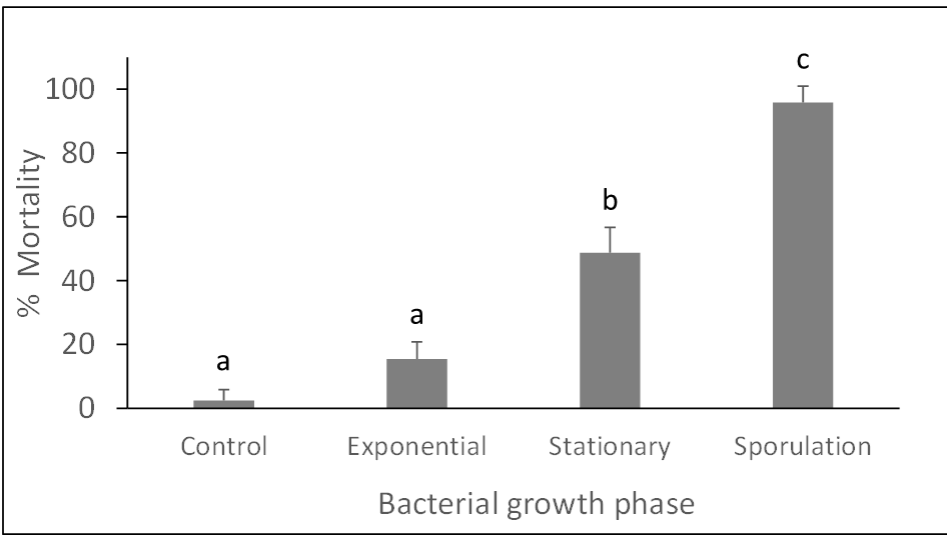
Figure 2. Mortality percentage (mean ± sd) of Meloidogyne incognita exposed for 48 h to the culture supernatant of Brevibacillus laterosporus at different growth phases. Different letters above bars indicate significantly different means (one-way ANOVA, followed by DMRT test, p < 0.001).